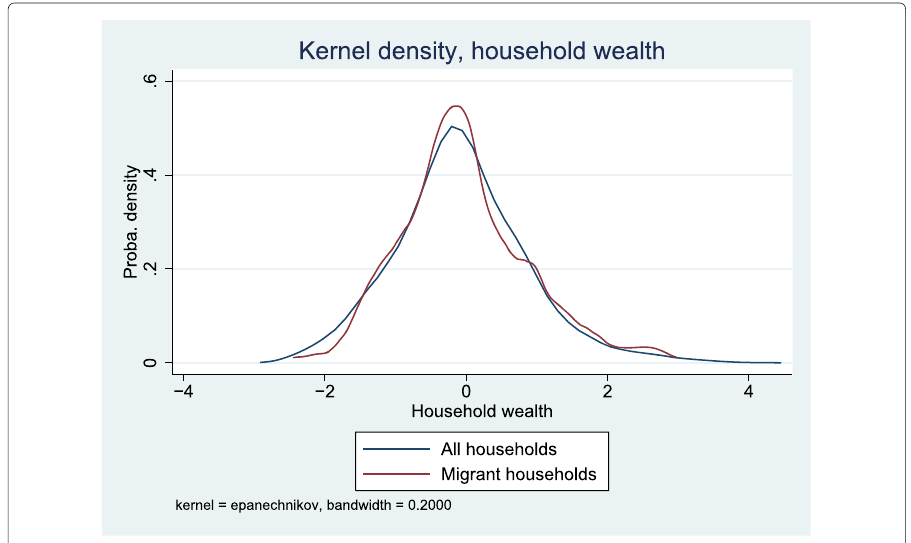
Fig. 4 Household wealth (post-departure) and